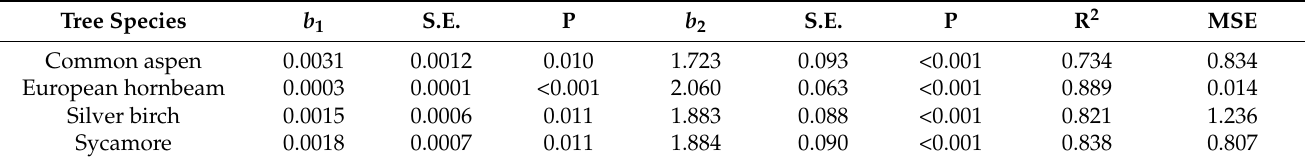
Table 4. Species-specific models for estimating total leaf area at a tree level (m 2 ) based on equation in Figure 1d using diameter at stem base d 0 as a predictor. Meaning of abbreviations is explained in Table 1.